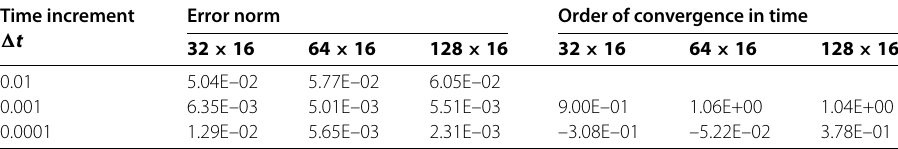
Table 2 Computed error norms and the order of convergence for Test 2 Time increment Error norm Order of convergence in time (cid:3) t 32 × 16 64 × 16 128 × 16 32 × 16 64 × 16 128 × 16